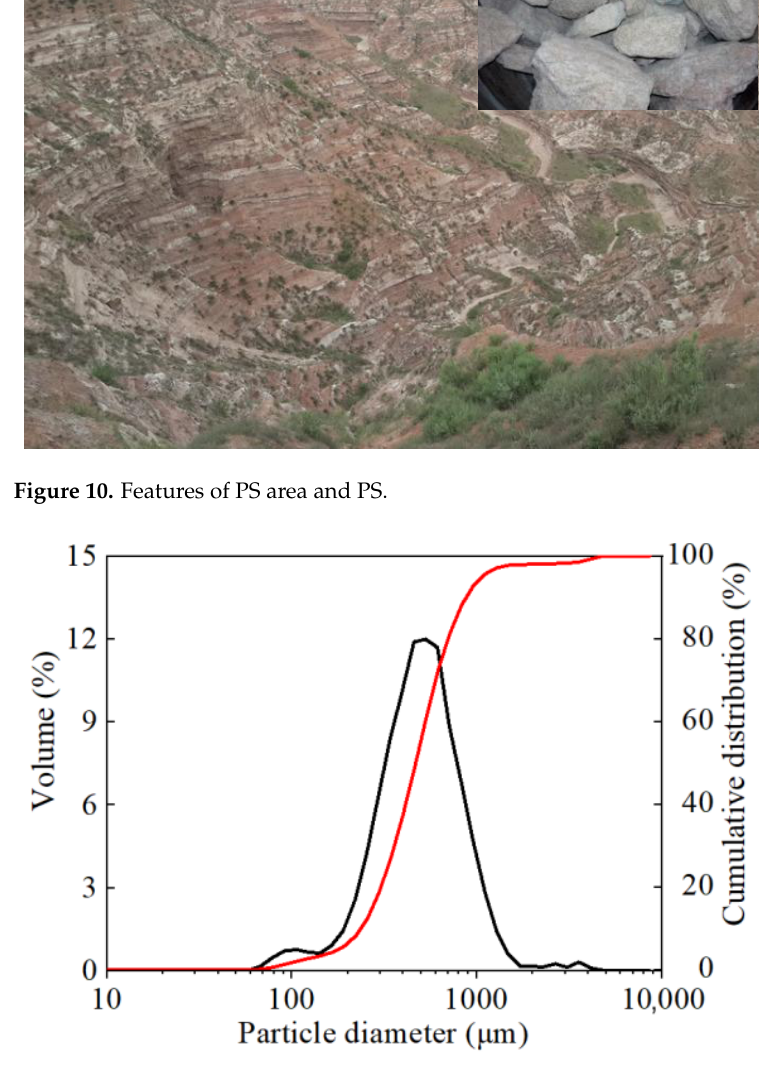
Figure 11. Particle size distribution curve of PS. Table 1. Composition of PS (XRF).